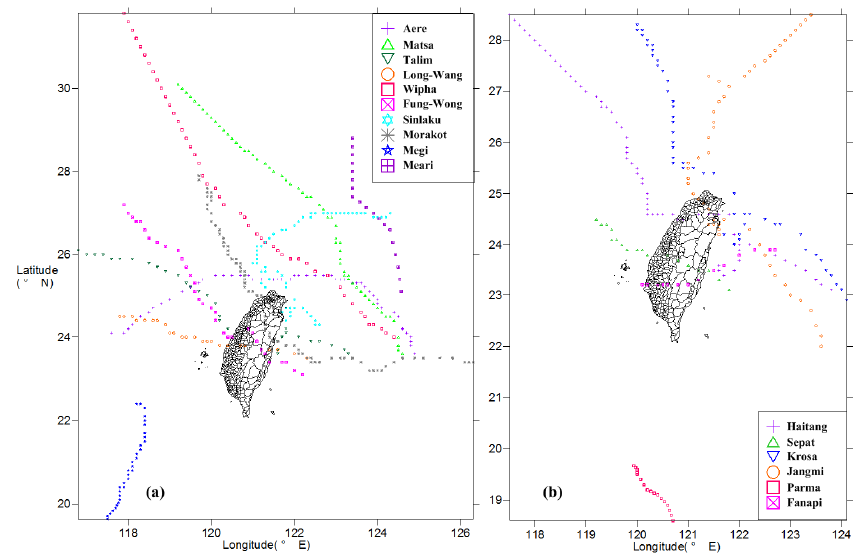
Figure 9. Moving paths of typhoons used in model construction: ( a ) training; ( b )